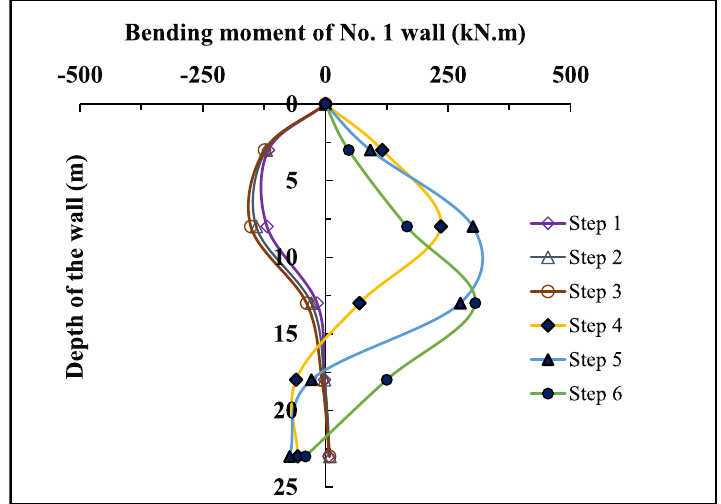
Figure 5. Bending moment of wall No. 1.